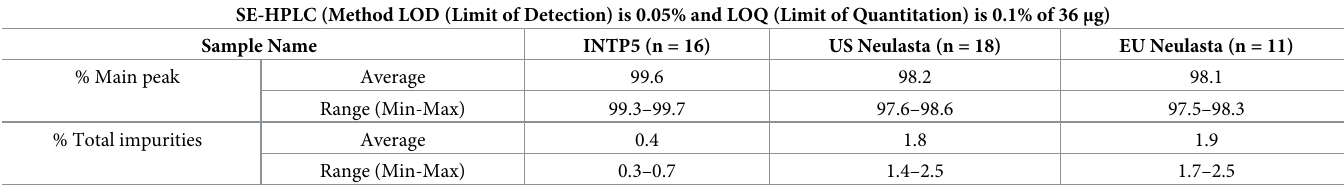
Table 7. Quantitative purity analysis of INTP5, US Neulasta and EU Neulasta using SEC-HPLC. SE-HPLC (Method LOD (Limit of Detection) is 0.05% and LOQ (Limit of Quantitation) is 0.1% of 36 μ g)